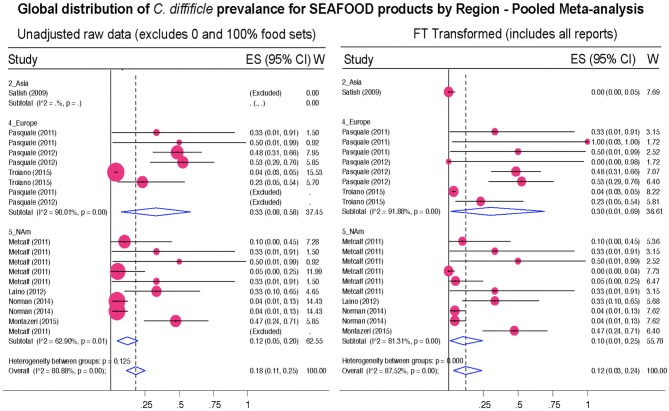
Global Prevalence of C. difficile in Seafood. Untransformed data (left) and Freeman–Tukey Double Arcsine Transformation (right).